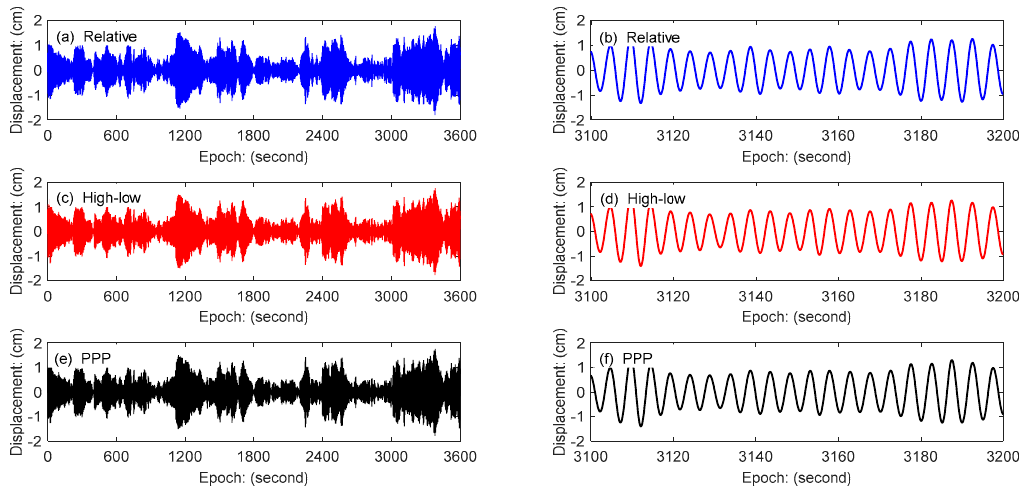
Figure 11. Displacement comparison of the first modal in the X direction: ( a ) relative positioning method, ( b ) is enlargement of the detail of ( a ); ( c )combining high- and low-rate GPS method, ( d ) is enlargement of the detail of ( c ); ( e ) PPP method, and ( f ) is enlargement of the detail of ( e ).